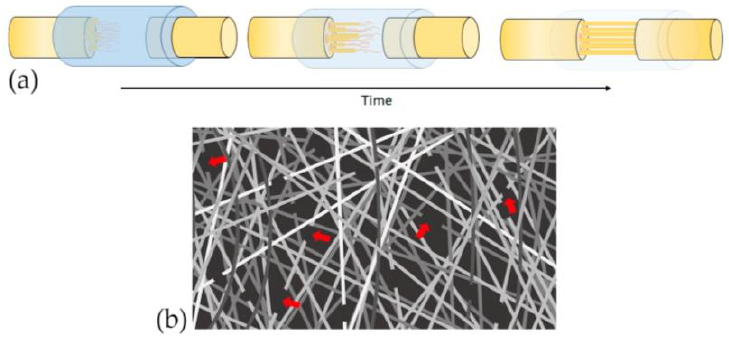
Figure 3. Biodegradability of polymeric scaffolds over time: ( a ) represents scaffold biodegradation at a controllable rate according to axonal growth rates towards the distal nerve site; ( b ) fiber degradation is indicated by the arrows.